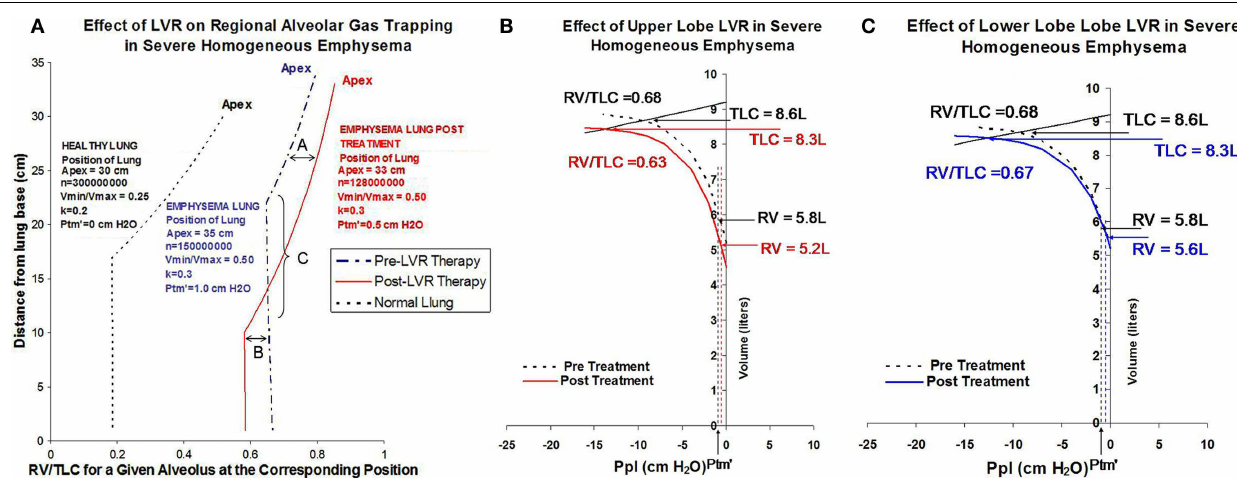
FIGURE 3 | (A) Shows simulations depicting regional RV/TLC values for normal lung (black dashed line), severe homogeneous emphysema (blue dashed line), and following lung volume reduction therapy in homogeneous emphysema (red solid line) on regional RV/TLC values. Lung volume reduction therapy in this example is modeled as decreasing the overall size of the lung from 35cm apex-to-base to 33cm apex-to-base, decreasing the total number of alveoli from 150,000,000 to 128,000,000, and shifting airway closing pressure from 1 to 0.5cm H 2 O.The increase in P tp resulting from volume reduction therapy distends alveoli in the upper lung fields, increasing regional RV/TLC ratios, labeled in this figure as effect “A.”The decrease in P tm (cid:48) resulting from lung volume reduction